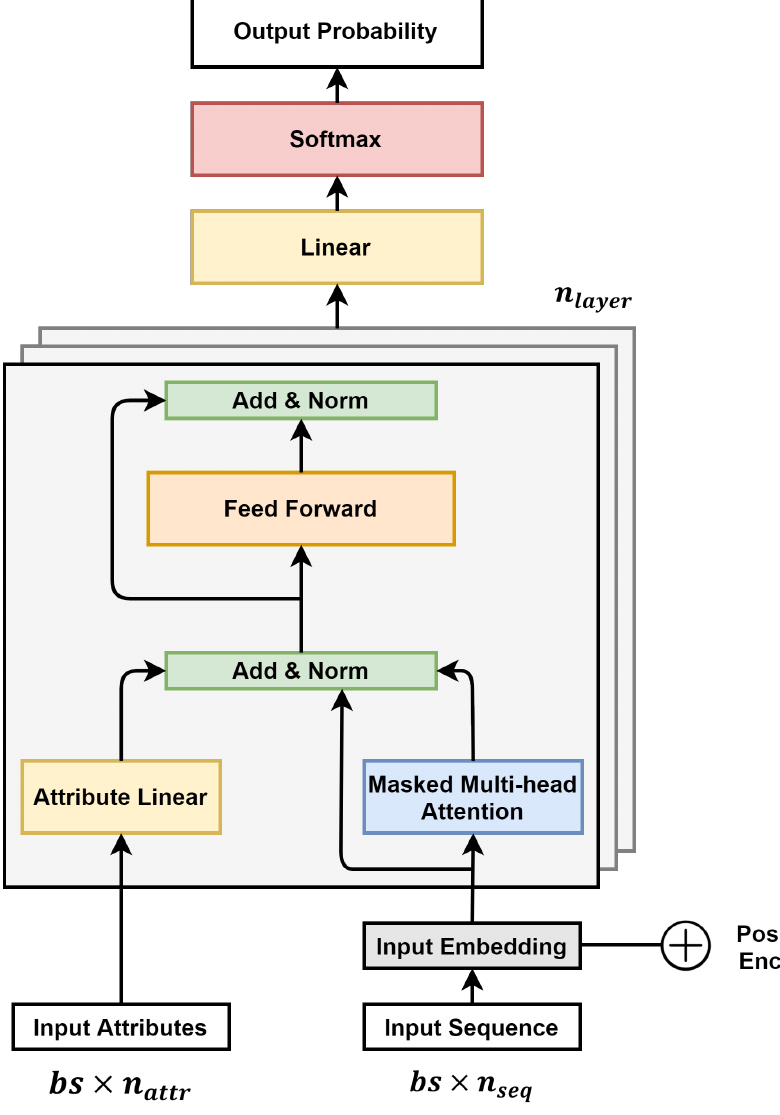
Figure 5. POP-ON (Prediction of Process Using One-way Language Model based on NLP Approach) model